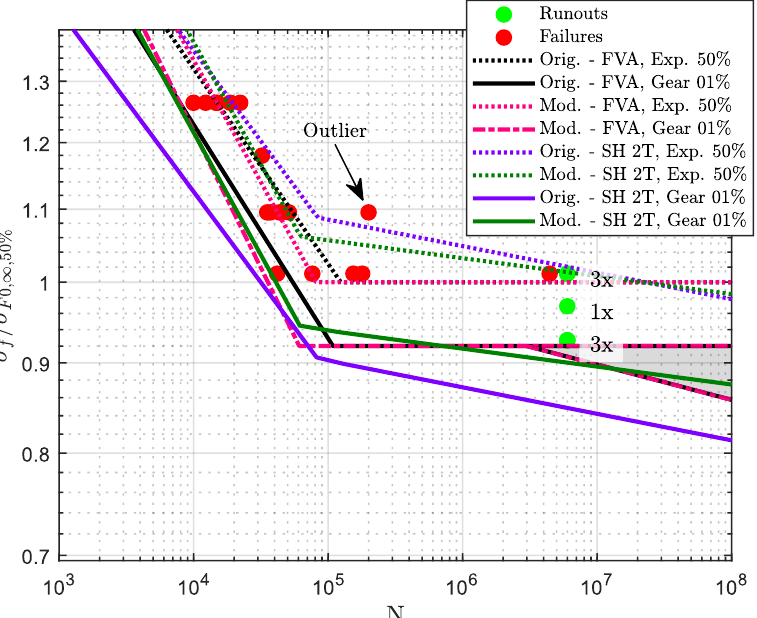
Figure 13. Comparison of the two estimation methods for exemplary campaign D from experi- mental FZG database [24] (Orig.) and excluding an outlier data point (Mod.).